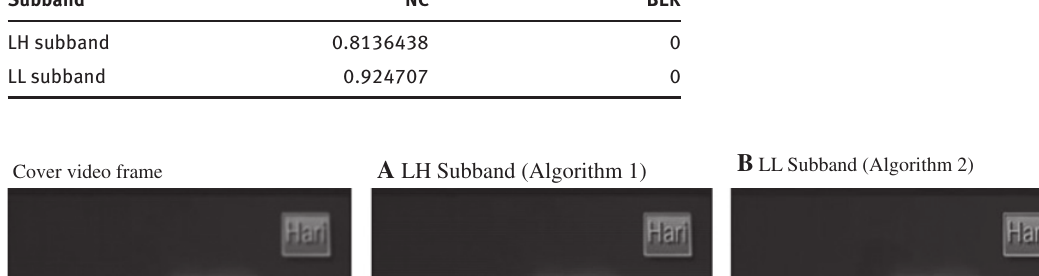
Performance of the system with LH Subband shows max. PSNR(57.622821 dB) and min. MSE using Ad.avi video with Pepper.jpg, image and with LL subband, Ad.avi video with mandril.jpg shows max. PSNR(57.622821 dB) and min. MSE value, represented in bold form in Table Table 3: Comparative Analysis of Algorithms 1 and 2. Subband